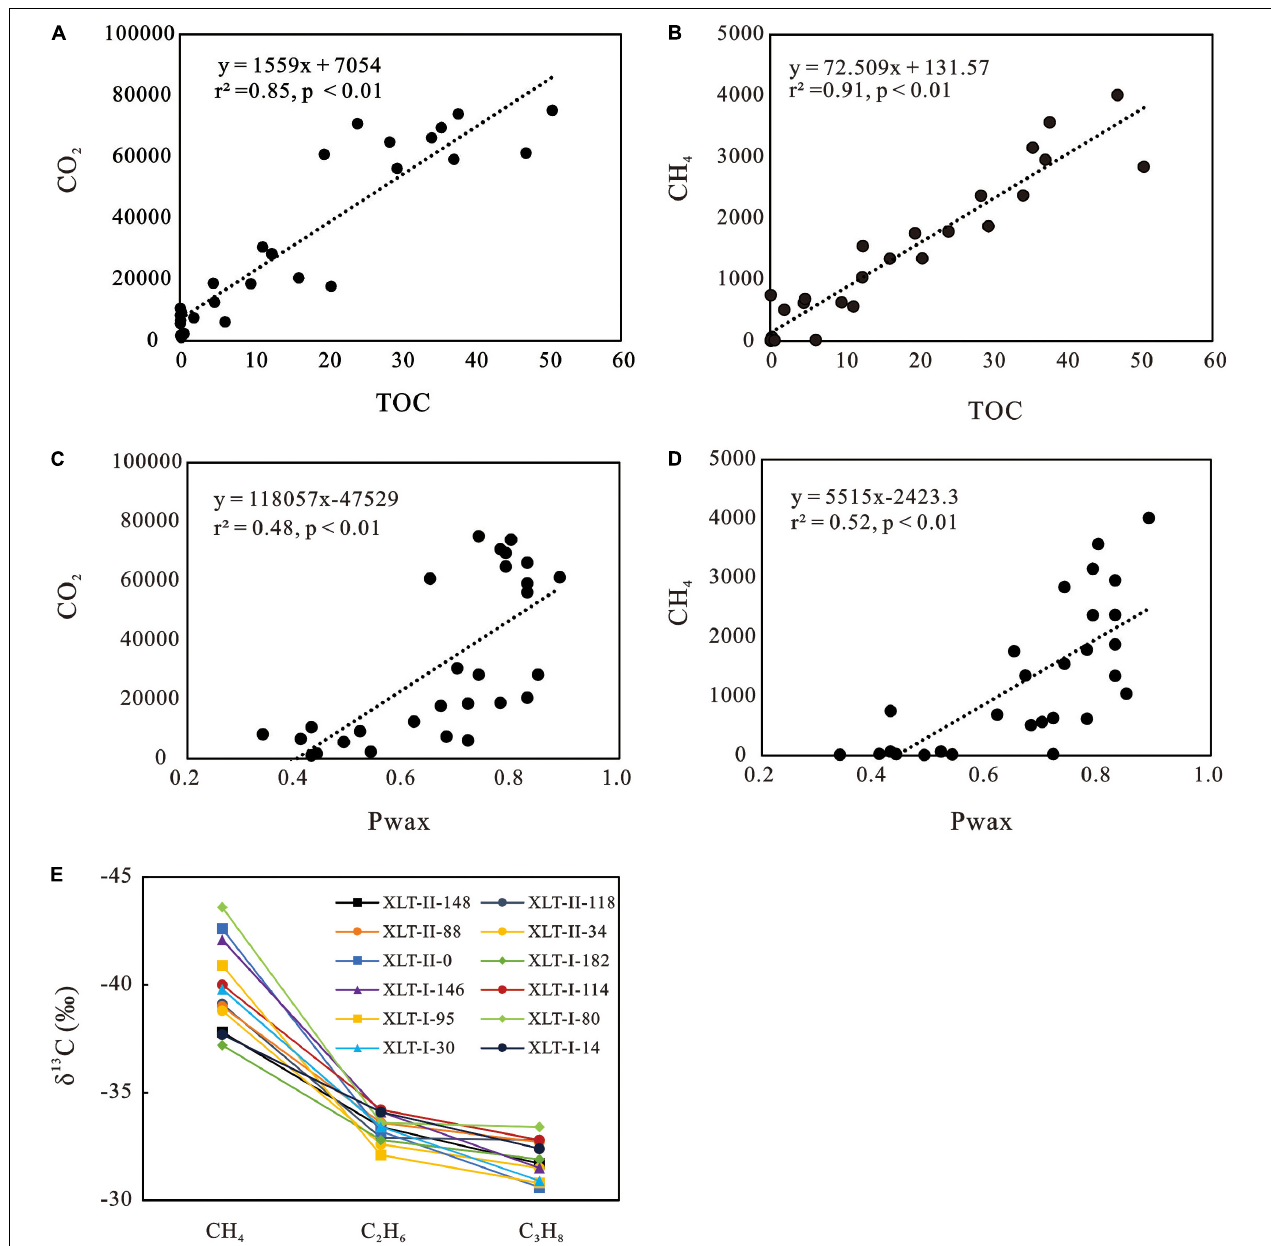
FIGURE 5 | Correlations between TOC contents and production rate of CO 2 and CH 4 (A,B) , and Pwax values and production rate of CO 2 and CH 4 (C,D) , and compound-specific carbon isotopes of CH 4 , C 2 H 6 and C 3 H 8 , respectively (E)